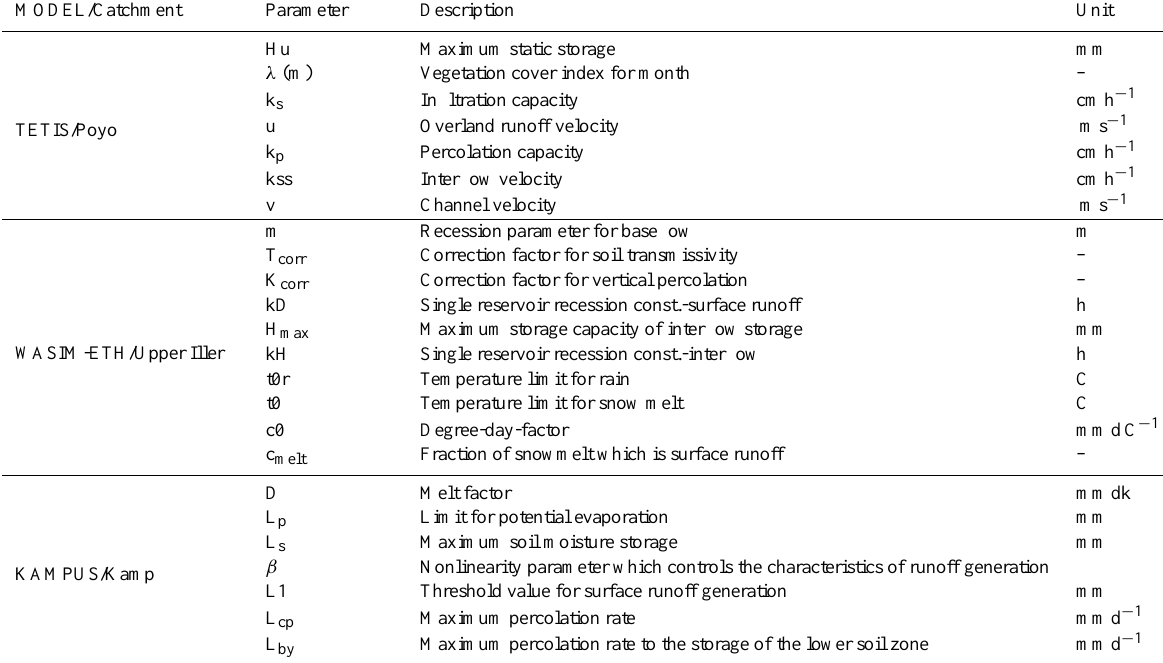
Table 4. Summary of the main model parameters identified at each case study.